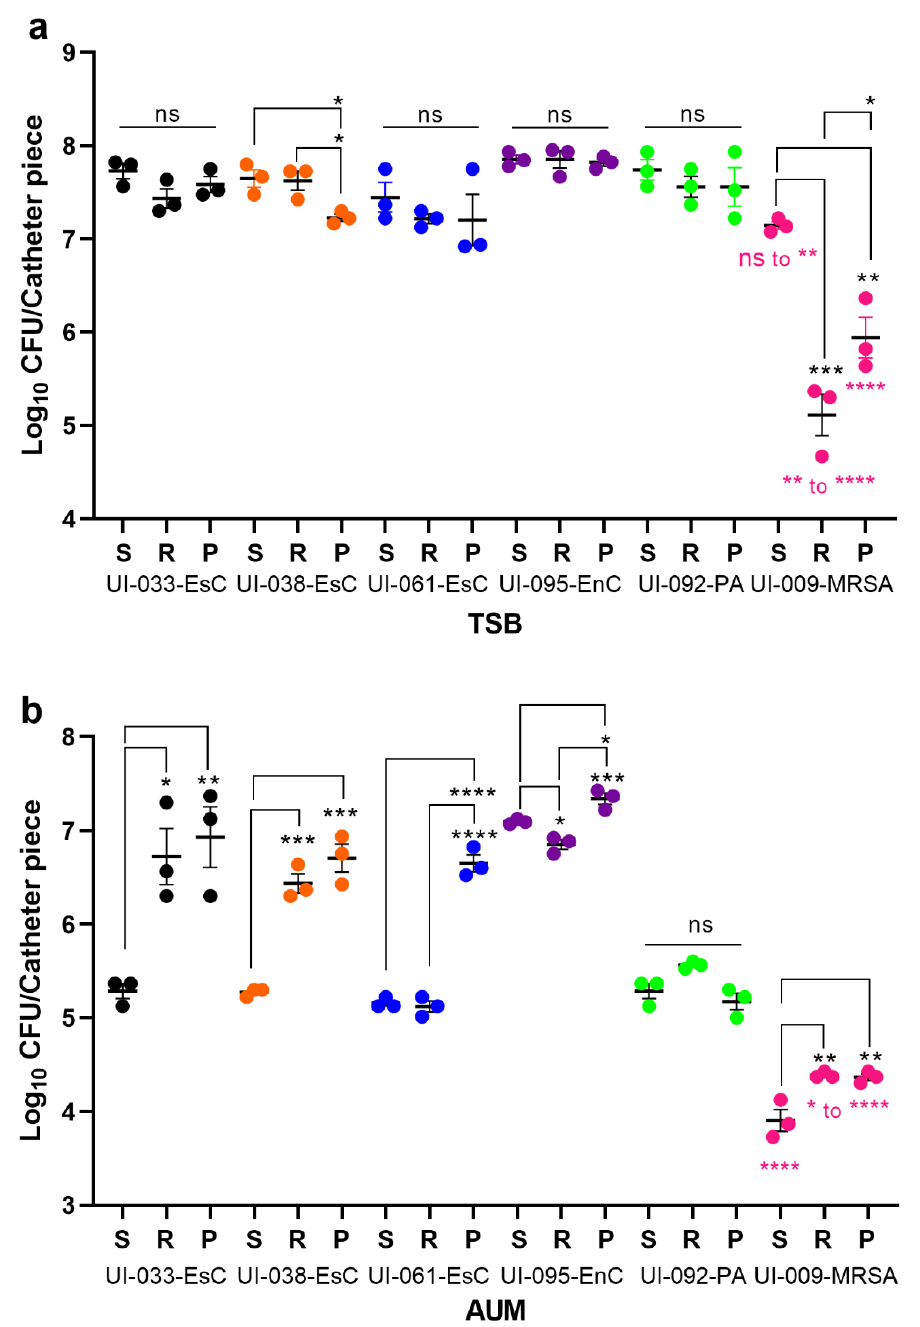
Figure 3. Artificial urine medium supports the growth of clinical uropathogens and their formation of biofilm on urinary catheters. Biofilms were allowed to develop for 24 h on 1.5-cm lengths of urinary catheters made of silicone (S), rubber (R), or PVC (P) incubated in TSB ( a ) or AUM ( b ). The amounts of biofilm formed by each isolate on each type of catheter material were compared. For five of the six isolates, biofilm biomass on silicone is significantly less than that formed on PVC; for four of the six isolates, biofilm biomass on silicone is less than that formed on rubber. Each dot represents an independent experiment; ns, no significance; * p < 0.05; ** p < 0.01; *** p < 0.001, **** p < 0.0001. Black asterisks indicate significant differences for each isolate and the different catheter materials; magenta asterisks indicate significant differences in biofilm biomass of UI-009-MRSA on each type of catheter material compared to the other